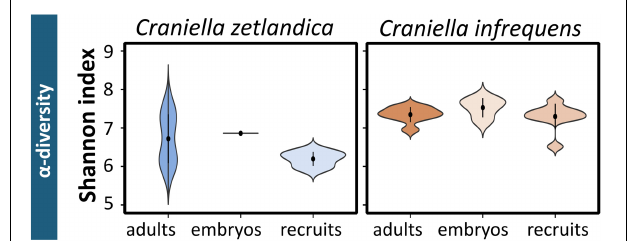
FIGURE 3 | Prokaryotic alpha-diversity for the sampled Craniella species. Shannon indices calculated for the different developmental stages of C . zetlandica and C . infrequens